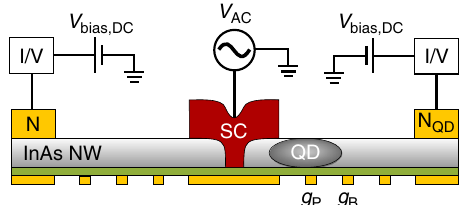
Fig. 5 Device geometry. Schematics of the cross-section of the device together with the circuit diagram.